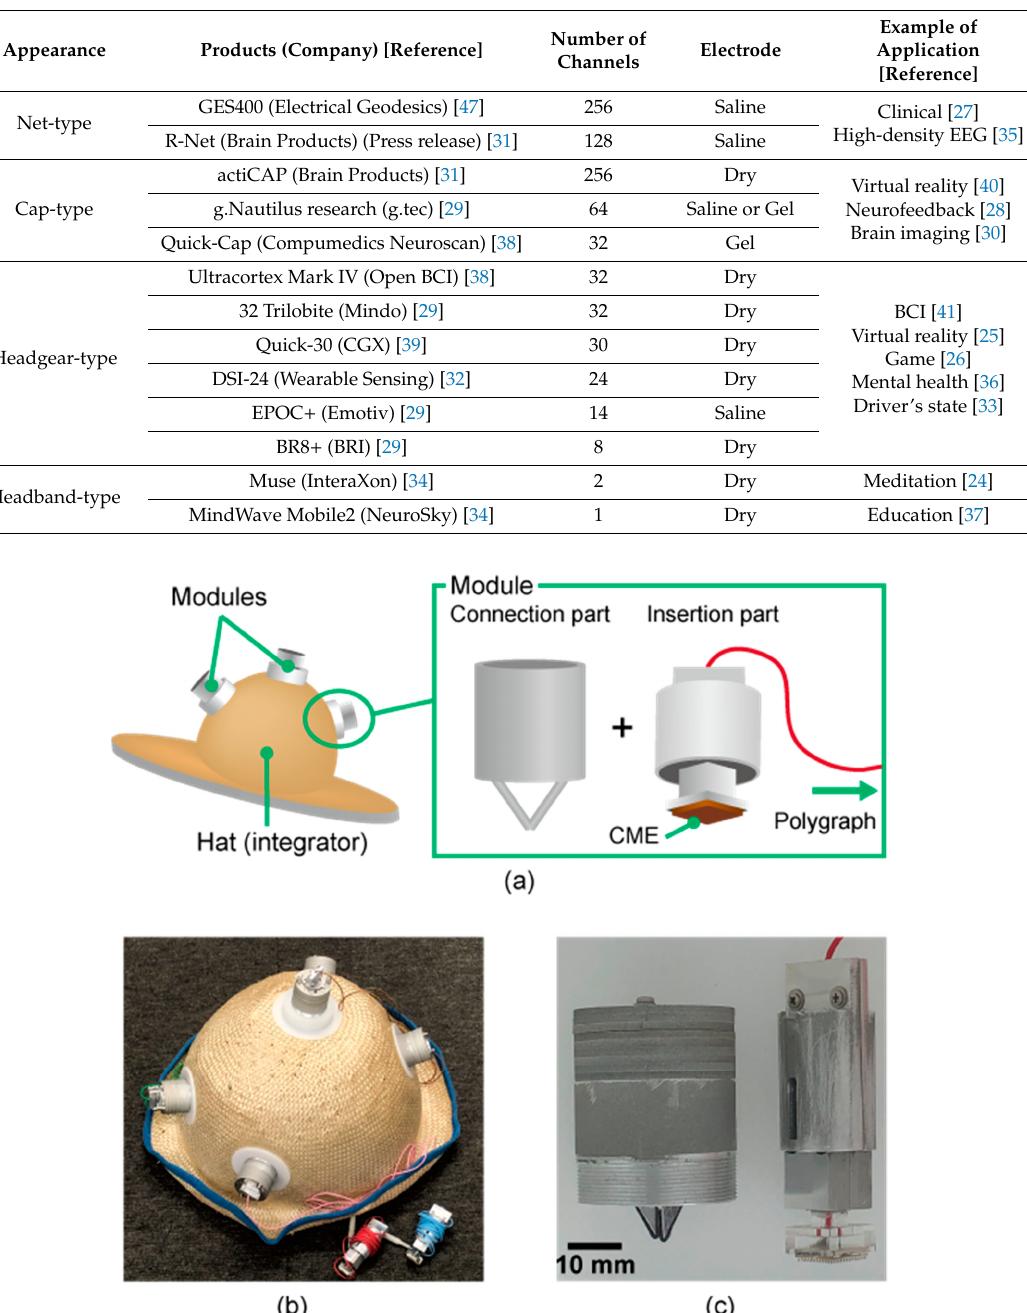
Table 1. Existing methods used in current electroencephalogram (EEG) devices.